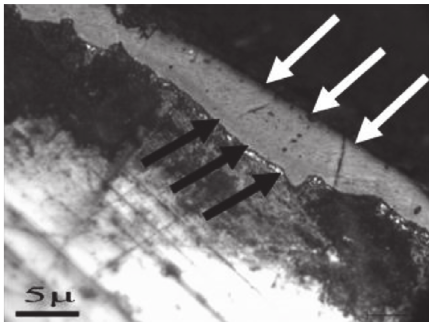
Figure 6: Optical microscopy image of corrosion products on the surfaces of reheater